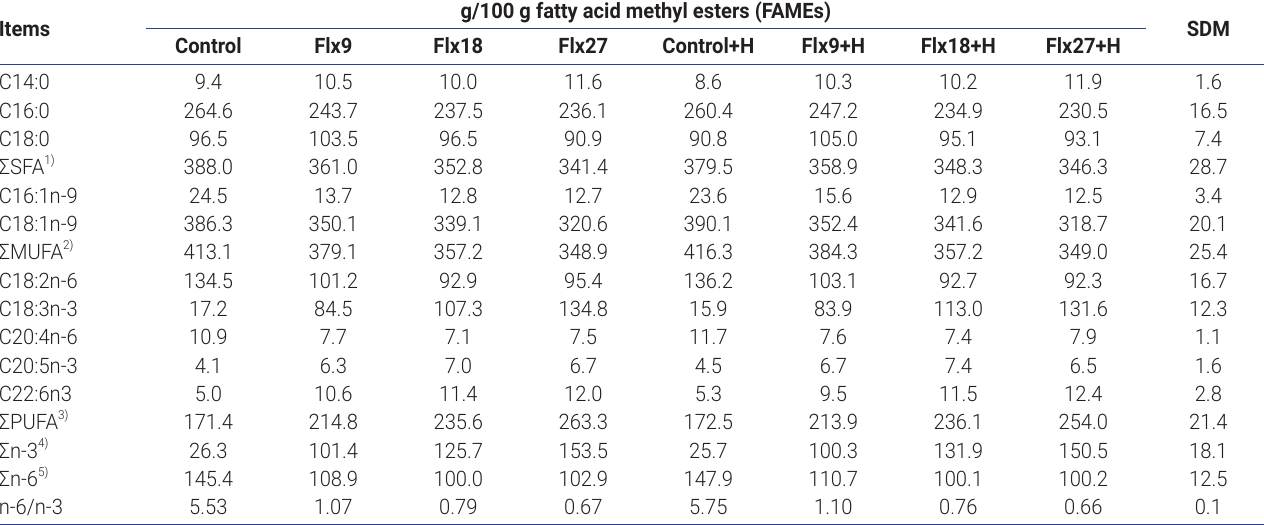
g/100 g fatty acid methyl esters